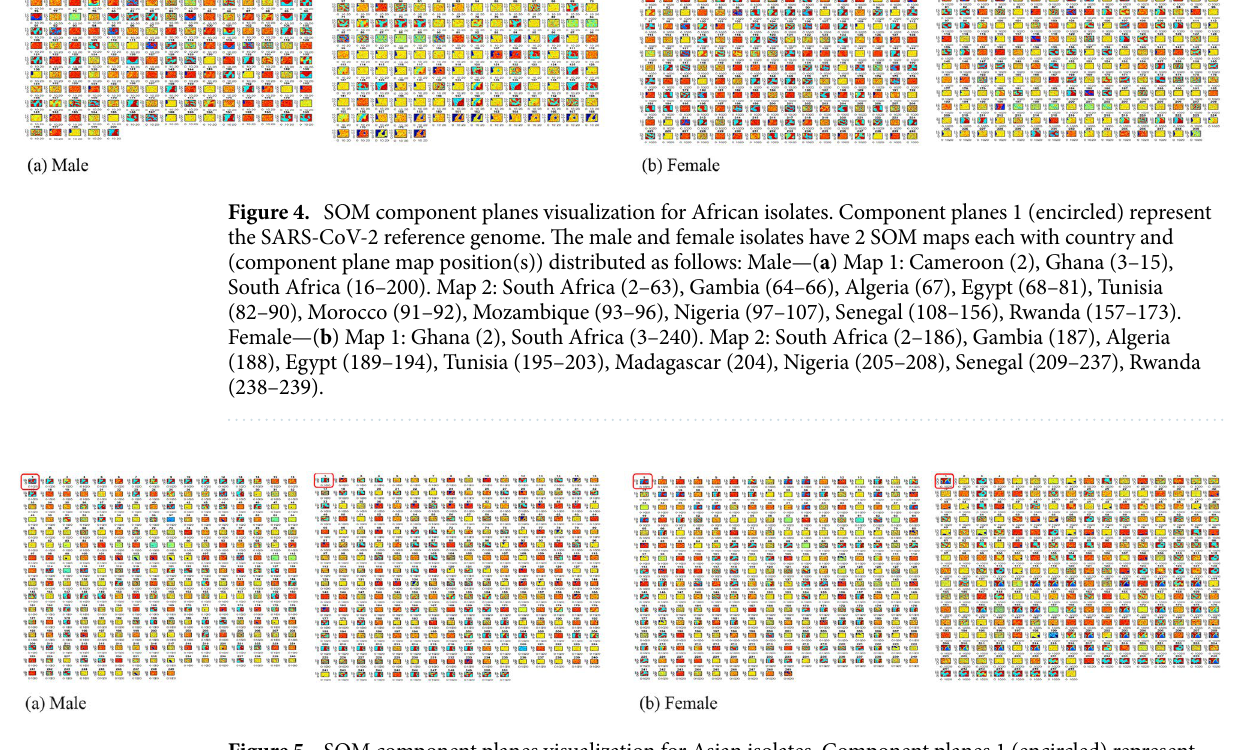
Figure 5. SOM component planes visualization for Asian isolates. Component planes 1 (encircled) represent the SARS-CoV-2 reference genome. The male and female isolates have 2 SOM maps each with country and (component plane map position(s)) distributed as follows: Male—( a ) Map 1: Singapore (2–18), Iraq (19), China (20–71), Kuwait (72–74), Malaysia (75–94), Sri Lanka (95–109), Bangladesh (110–119), India (120–249). Map 2: India (1–145), South Korea (146–149), Kazakhstan (150), Indonesia (151–164), Turkey (165–180), Iran (181– 184), Taiwan (185–191), Vietnam (192–200), Israel (201), Saudi Arabia (202–221), Mongolia (222–224),